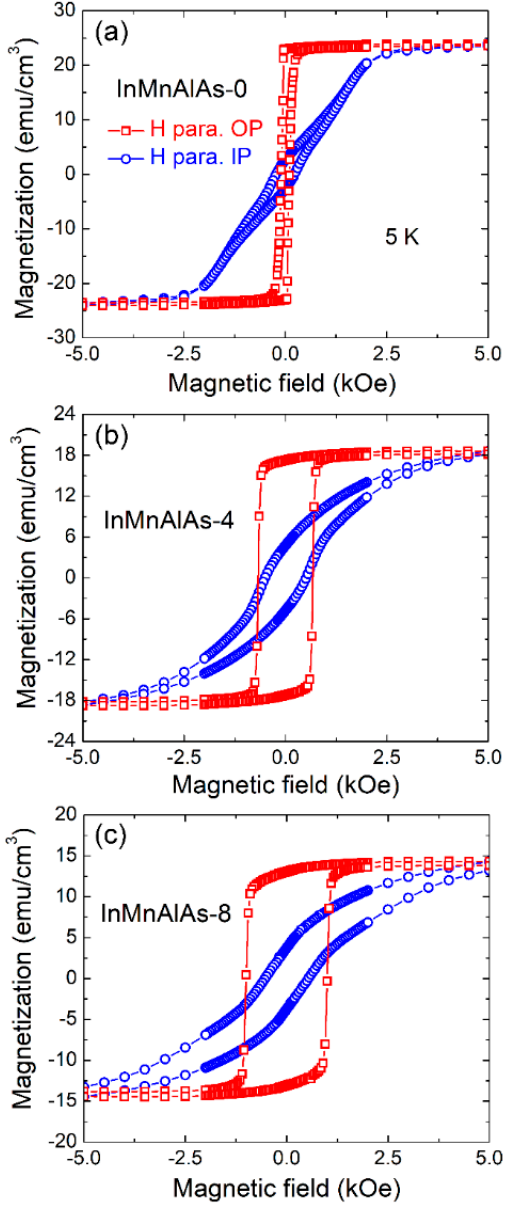
Figure 5. The magnetic field dependent magnetization of samples: ( a ) InMnAlAs-0; ( b ) InMnAlAs-4; ( c ) InMnAlAs-8, when the magnetic field is applied parallel (circles) and perpendicular (squares) with the plane.